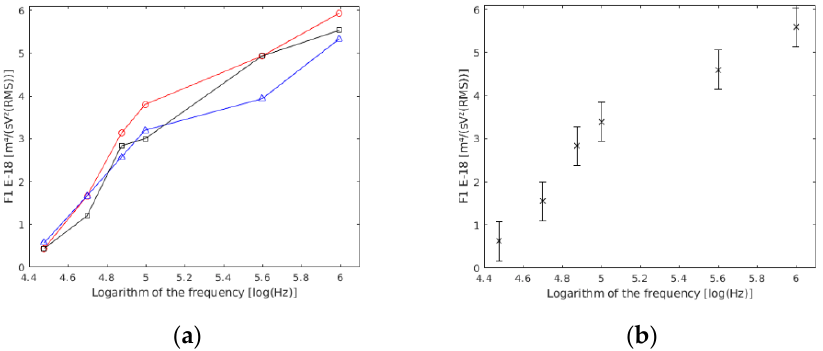
Figure 4. ( a ) F 1 results based on the frequency obtained in each of the experiences conducted with double yeast cells. F 1 units are m 4 / (sV 2 (RMS)). ( b ) Results of the three experiments together. The obtained data are shown in Table